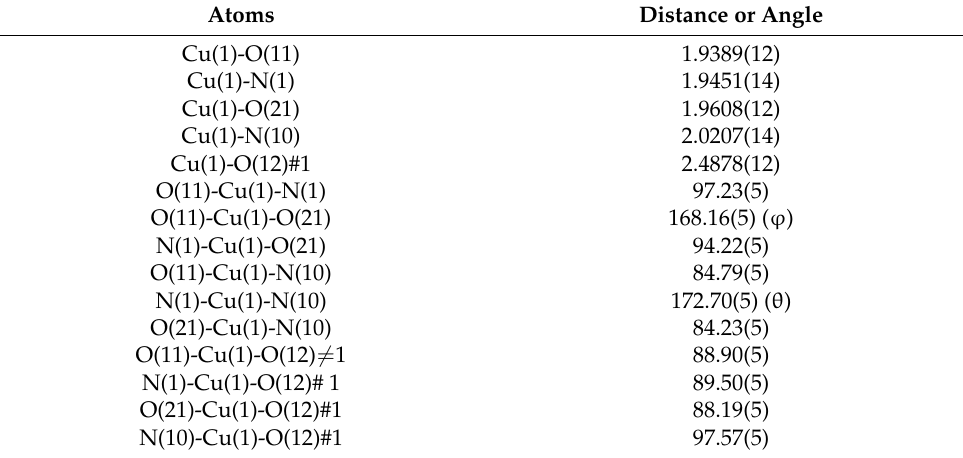
Figure 2. Structure and numbering scheme for non-hydrogen atoms in the asymmetric unit of 1 . The water molecule has partial occupancies in the two disordered represented positions. Symmetry codes: a = #1 = − x + 1/2, y − 1/2, − z + 1/2, b = #2 = − x + 1/2, − y + 1/2, − z, e = #5 = − x + 1/2, − y − 1/2, − z. Table 3. Coordination bond lengths (Å) and angles (°) in the crystal of compound 1 , {[Cu 2 (µ 4 - EDTA)(Him) 2 ] · 2H 2 O} n . See Figure 2 for numbering scheme of relevant